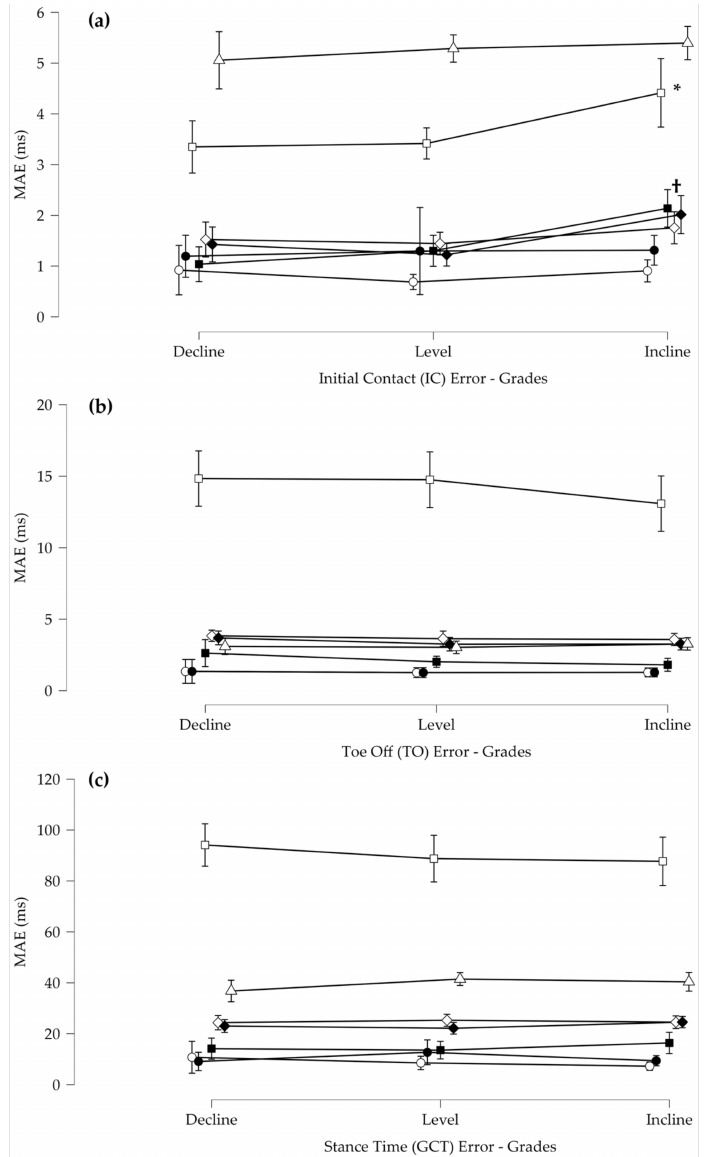
Figure 12. ( a ) Mean absolute error (MAE) for the initial contact events (IC) across all grades (* FCE3 was significantly higher on inclines than all other grades, and † indicates that FCE4 showed as significantly higher on inclines than at all other grades. ( b ) Mean absolute error (MAE) for the toe off events (TO) across all grades ( c ) Mean absolute error (MAE) for stance time (GCT) across all grades. Error bars represent standard